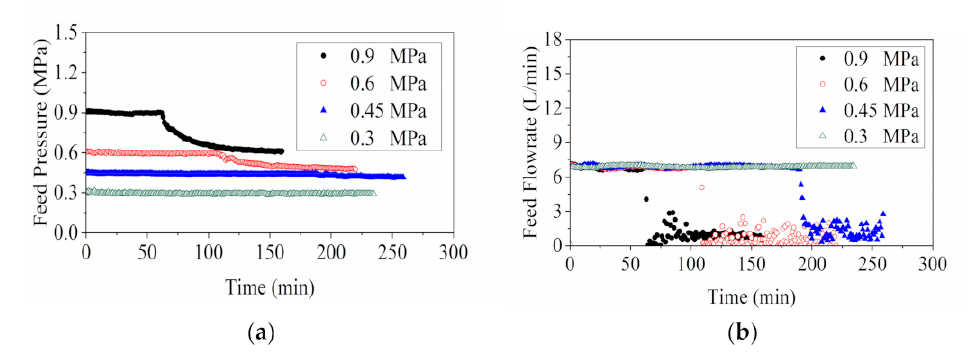
Figure 8. Demonstrations of the adverse impacts of foaming on the RO system performance in terms of ( a ) feed pressure and ( b ) feed